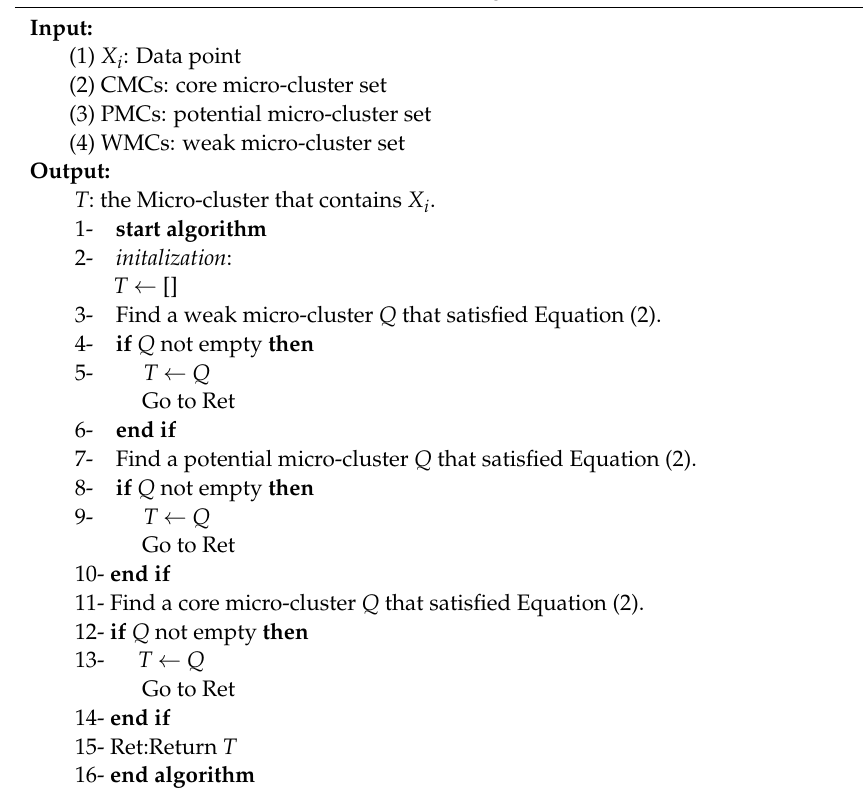
Algorithm 3: BOCEDS Micro-Cluster